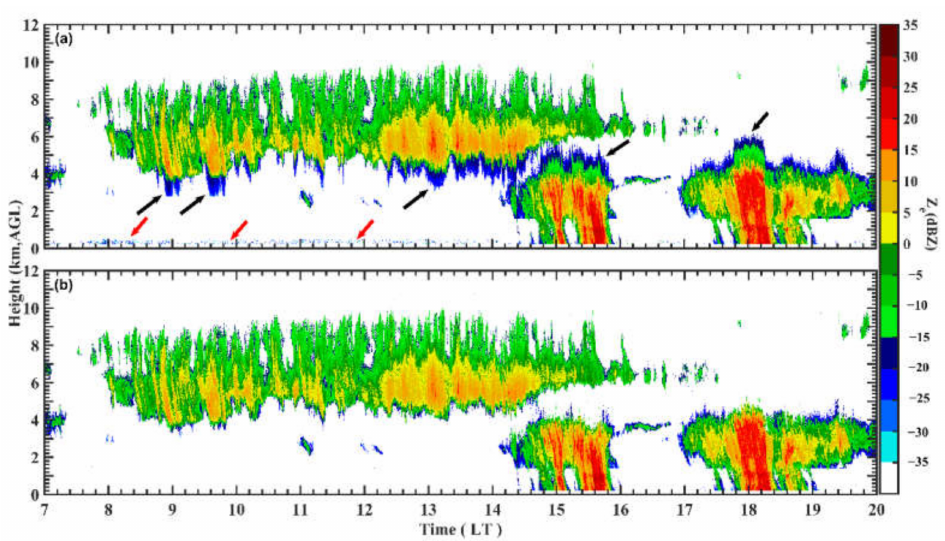
Figure 2. The time-height cross sections of radar original reflectivity factors ( Z e , dBZ) ( a ), and the reflectivity factors after quality control ( b ), as observed by Ka-MMCR at the LT site on 9 July